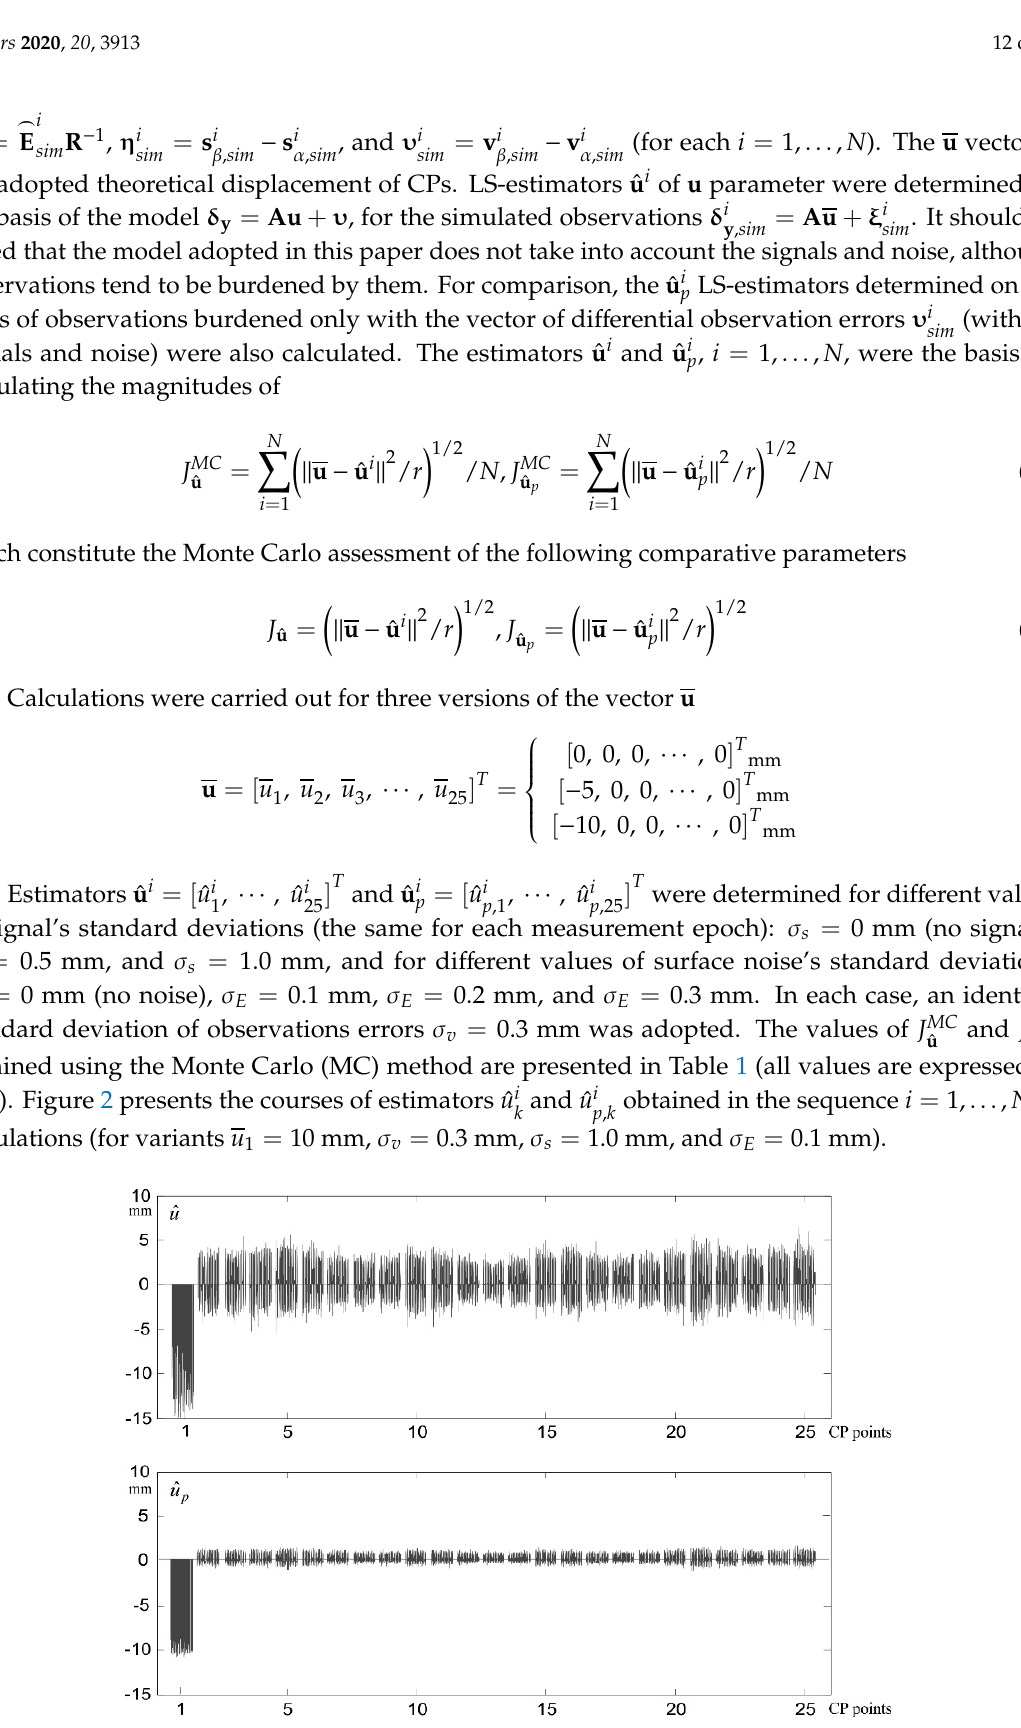
Figure 2. Estimators ˆ u i and ˆ u i , k = 1, ... ,25 of deterministic displacements of CPs, obtained in the k p , k sequence i = 1, ... ,5000 of simulations (for u 1 = 10 mm, σ v = 0.3 mm, σ s = 1.0 mm, and σ E = 0.1